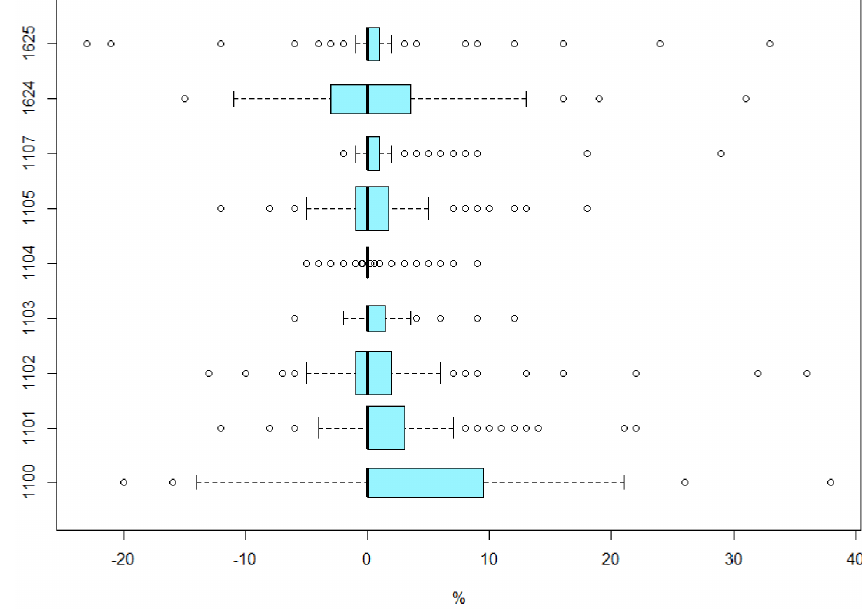
Figure 7. Percentage of stage curve extrapolation boxplots, 1969–1997. Here the boxes show the interquartile range (IQR), and the whisks present the border of ± 1.5 ×